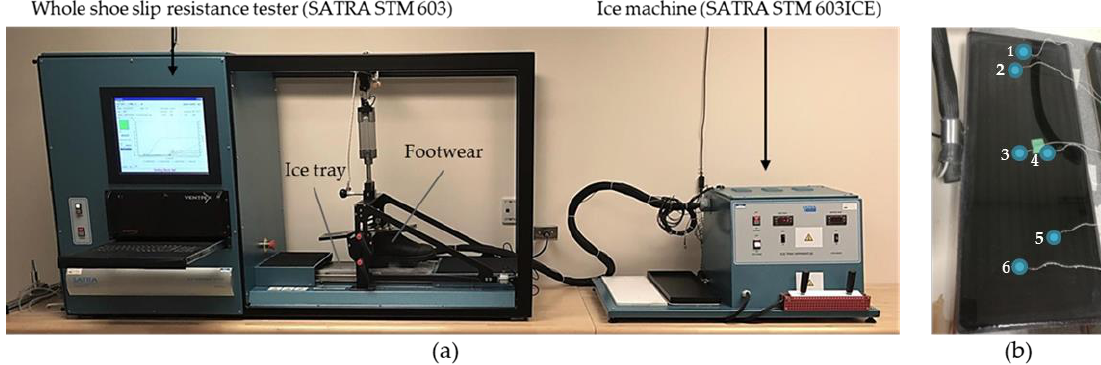
Figure 2. ( a ) The SATRA STM 603 Slip resistance tester (SATRA Technology Centre, Kettering, UK) and the STM 603ICE (SATRA Technology Centre, Kettering, UK) used in the mechanical method to evaluate the coefficient of friction (COF) between footwear and ice surfaces, ( b ) The blue circles show the thermistors positioned under and on the ice surface of the ice machine at KITE (Knowledge, Innovation, Talent, Everywhere)-Toronto Rehabilitation Institute-University Health Network.